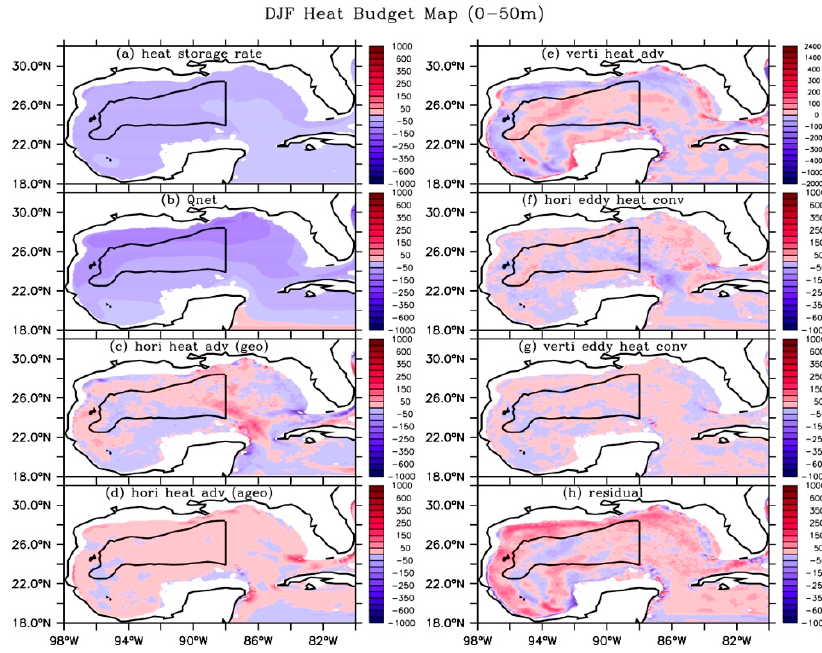
Figure 14. Same as Figure 13 but for those time-averaged over winter season (December–January– February; DJF).